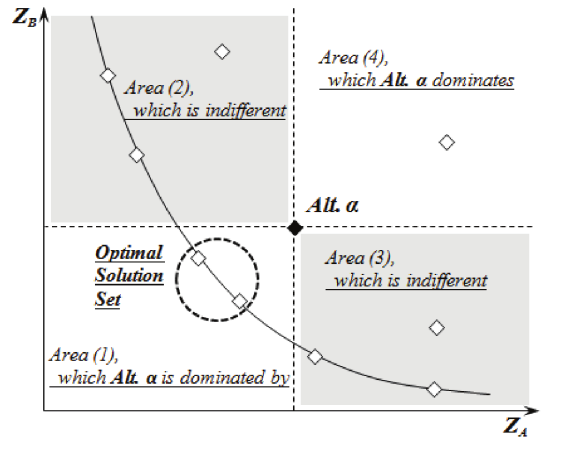
Fig. 2. Non-dominated area and the optimal solution set